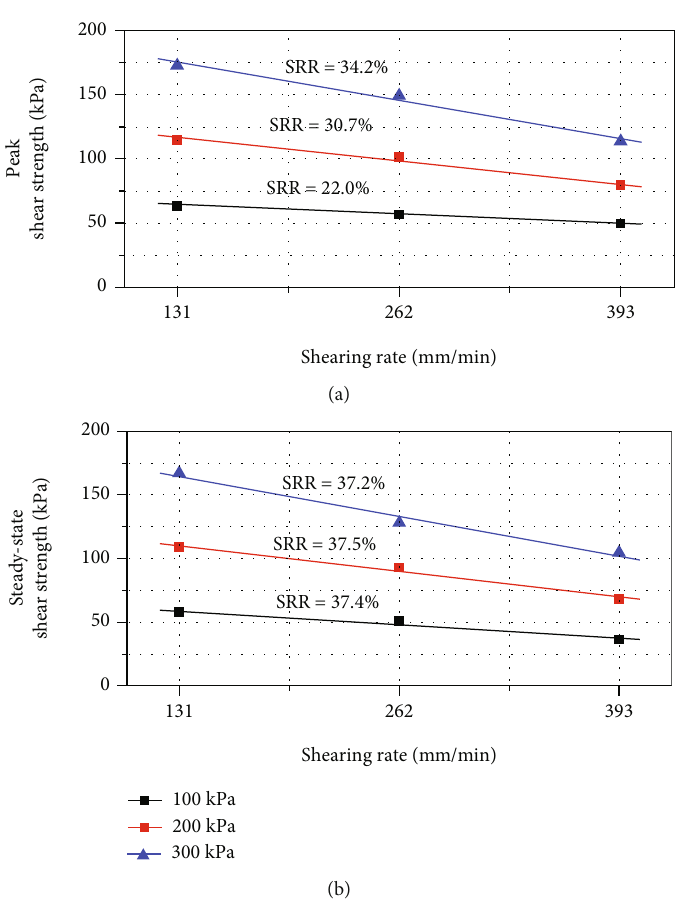
Figure 6: (a) Peak shear strength and (b) steady-state shear strength versus shearing rate.